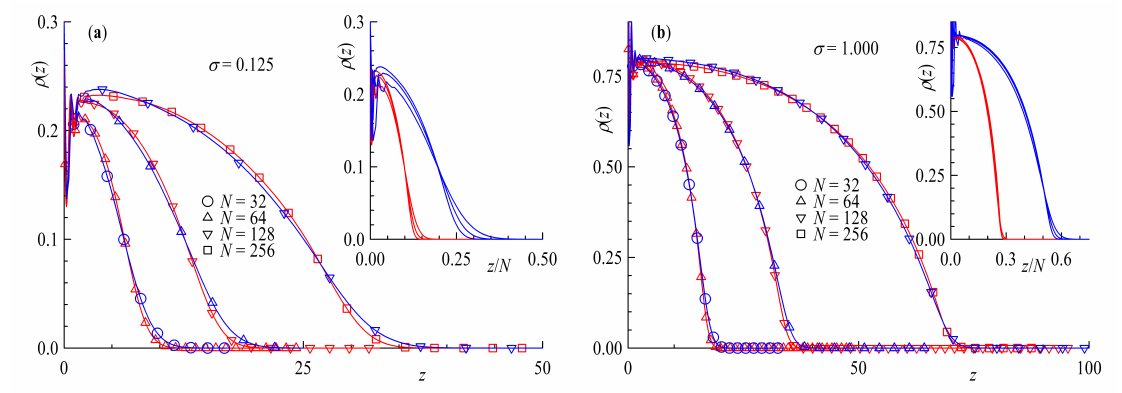
Figure 2. Density profiles ρ ( z ) as a function of distance from wall z for ( a ) surface coverage σ = 0.125 and ( b ) σ = 1.0. The insets show ρ ( z ) as a function of the distance scaled by the chain length z / N for the corresponding surface coverage. Red colors are rings and blue for